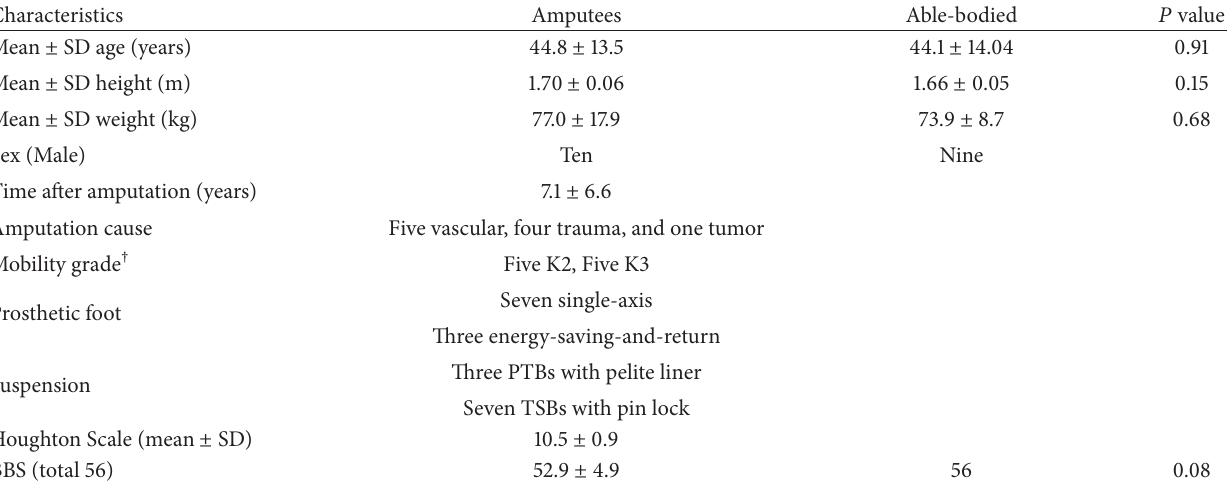
Table 1: Clinical and demographic characteristics of participants.